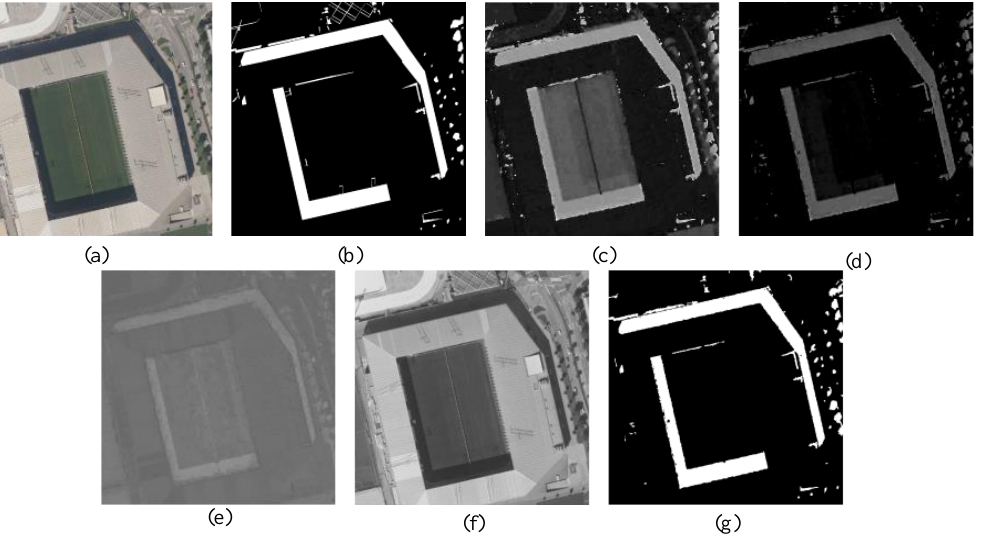
Figure 2. ( a ) Original Image; ( b ) ground truth; ( c ) H channel; ( d ) H-I channel; ( e ) S channel; ( f ) I channel; ( g ) shadow-detection results.